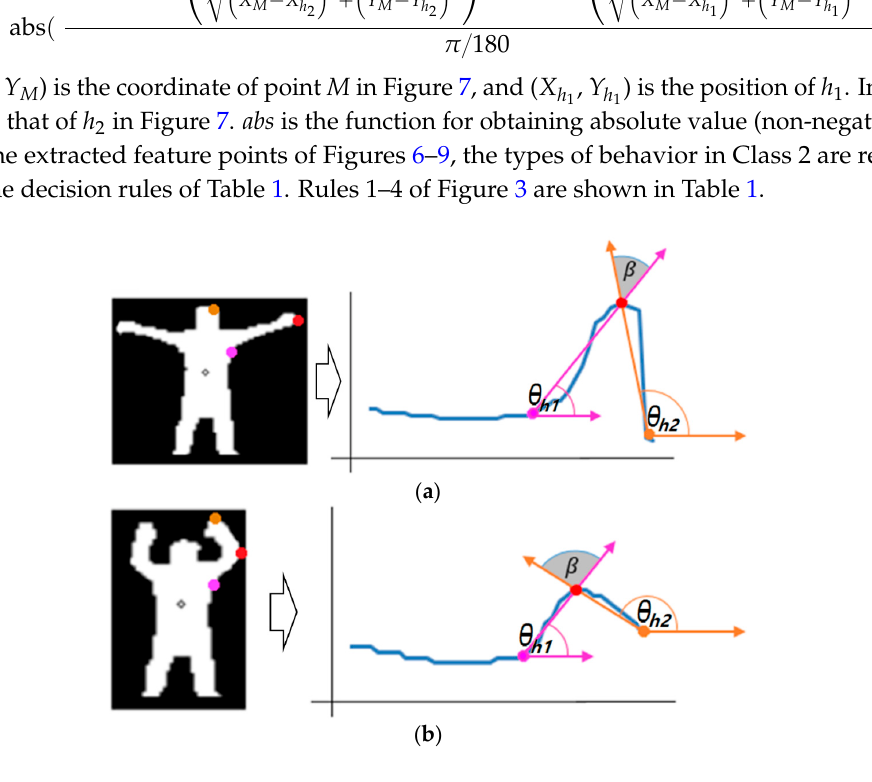
Figure 9. Examples of two types of hand waving by ( a ) unfolding; and ( b ) bending of the user’s arm. Table 1. Decision rules for recognizing the types of behavior in Class 2.